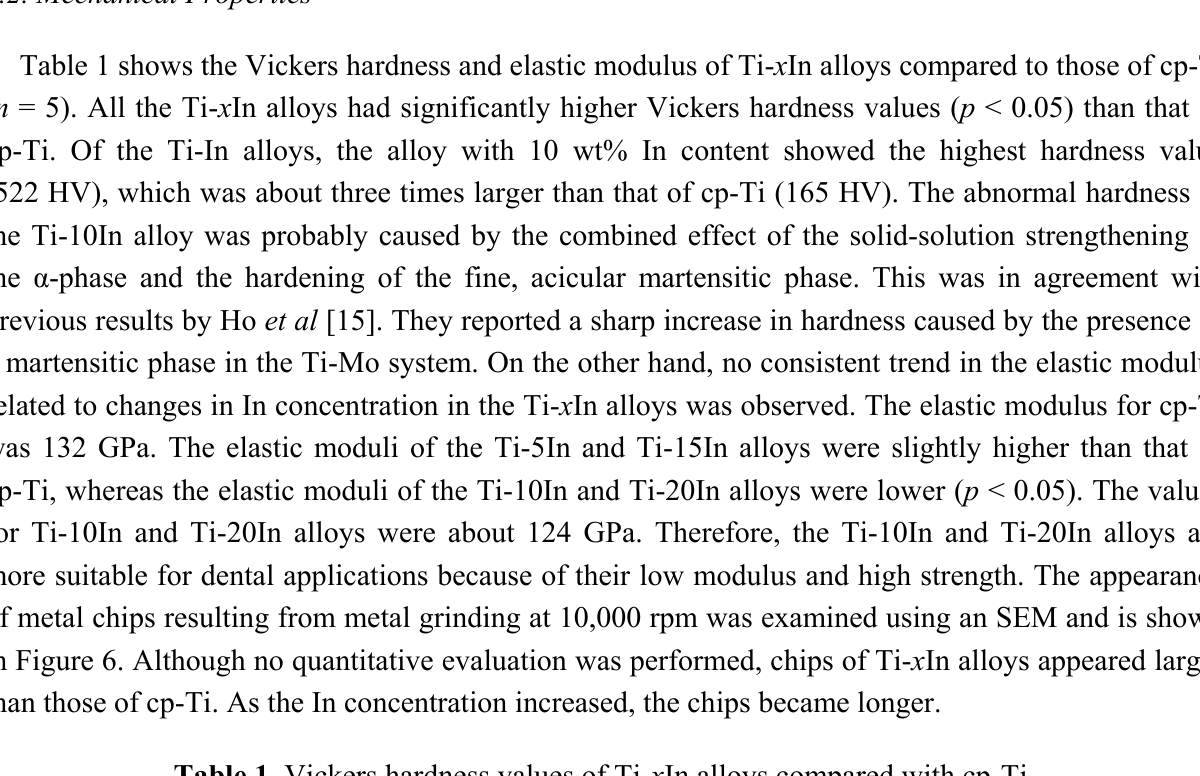
Table 1. Vickers hardness values of Ti- x In alloys compared with